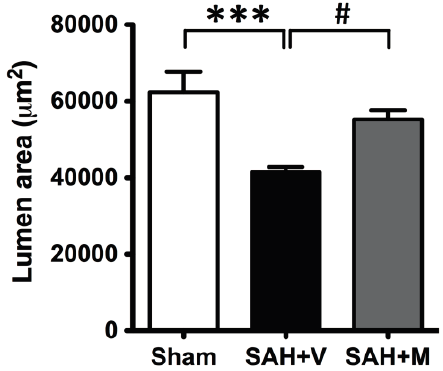
Figure 2. Memantine attenuated the delayed vasospasm. Measurements of lumen area of